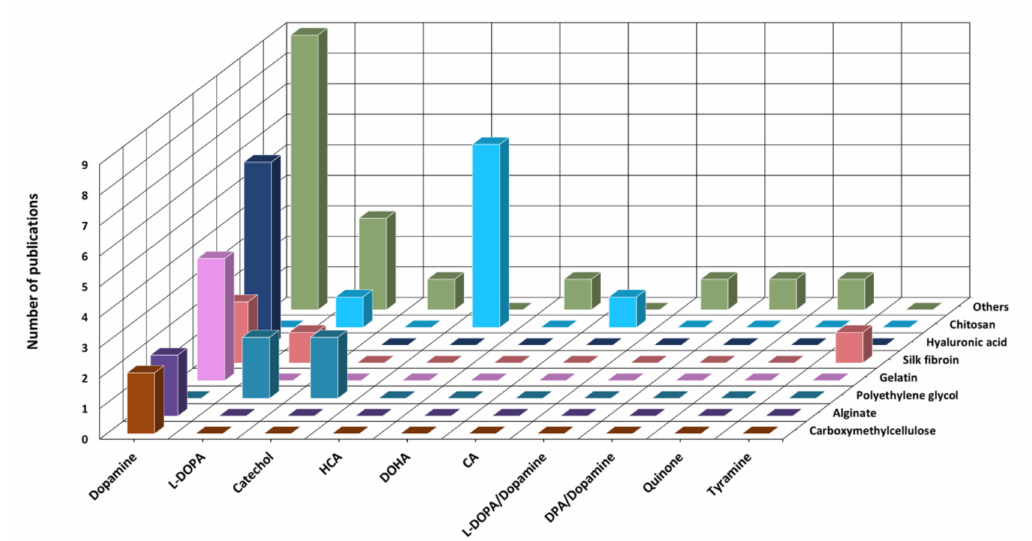
Figure 4. Graphical illustration of the final group of selected manuscripts based on the type of substituent per polymer. L- DOPA: 3,4-dihydroxy-L-phenylalanine; HCA: hydrocaffeic acid; DOHA: dihydroxybenzenepropionic acid; CA: caffeic acid;